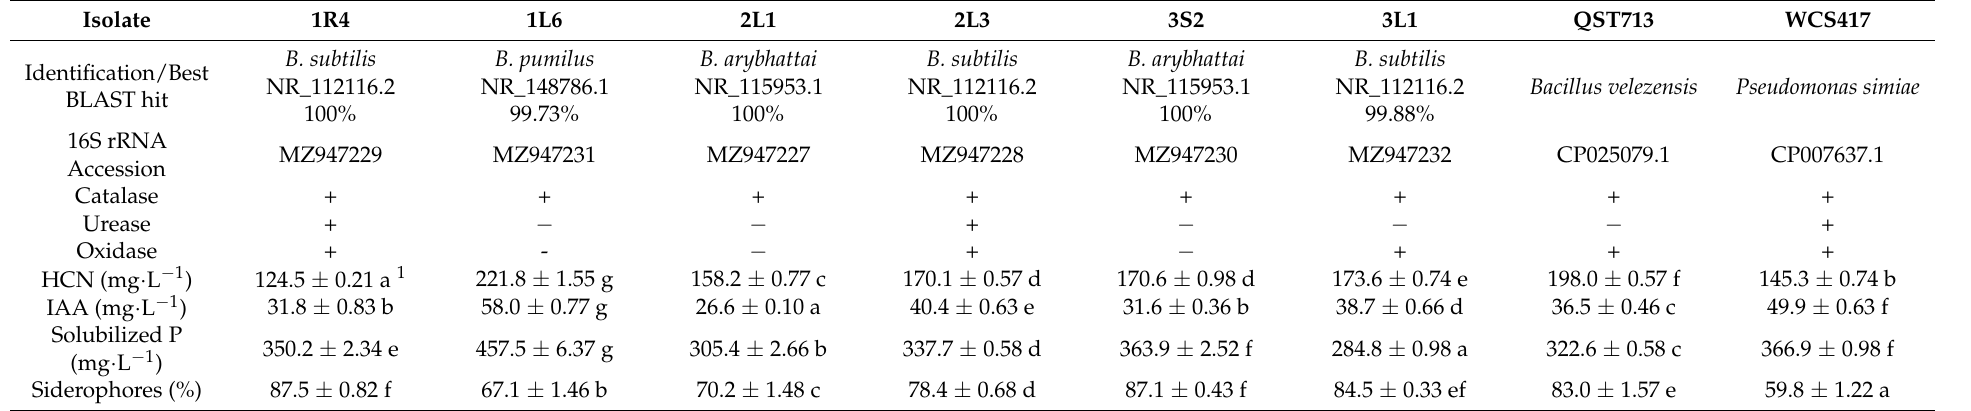
Table 2. 16S rRNA homology of selected endophytic isolates of rapeseed, their enzymatic characteristics, and PGP trait